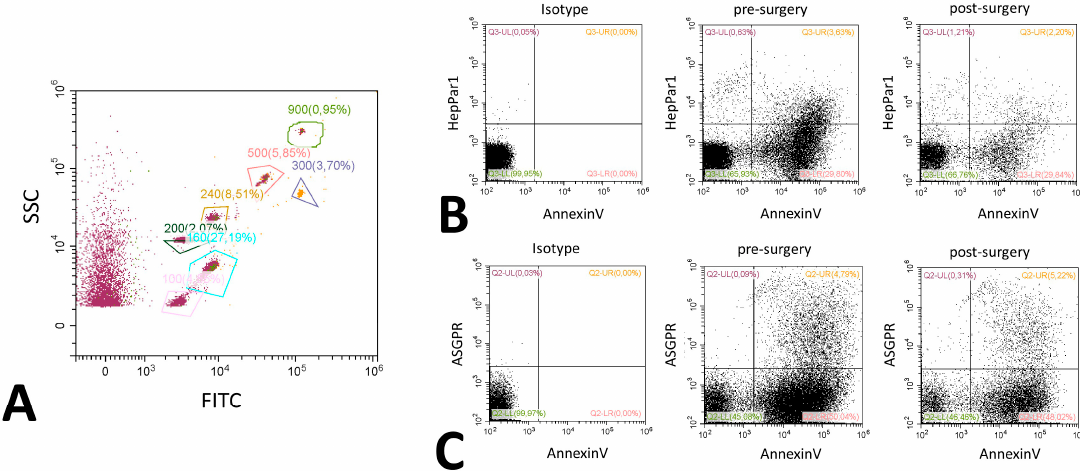
Figure 5. Representative flow cytometry dot plots. Dot plots for bead-based size estimation showing a bead mix labeled with FITC and an unlabeled fraction ( A ). The various gates are labeled with the size of the measured beads, percentages represent the relative number of beads measured compared to the whole sample. Dot plots are further shown for Annexin V and HepPar1 ( B ) and ASGPR and Annexin V ( C ). All examples are given before and after surgery. A representative isotype control picture is included in the panel. Gating was performed according to the values obtained in the histograms, percentages display the relative amount of events in comparison to the total event